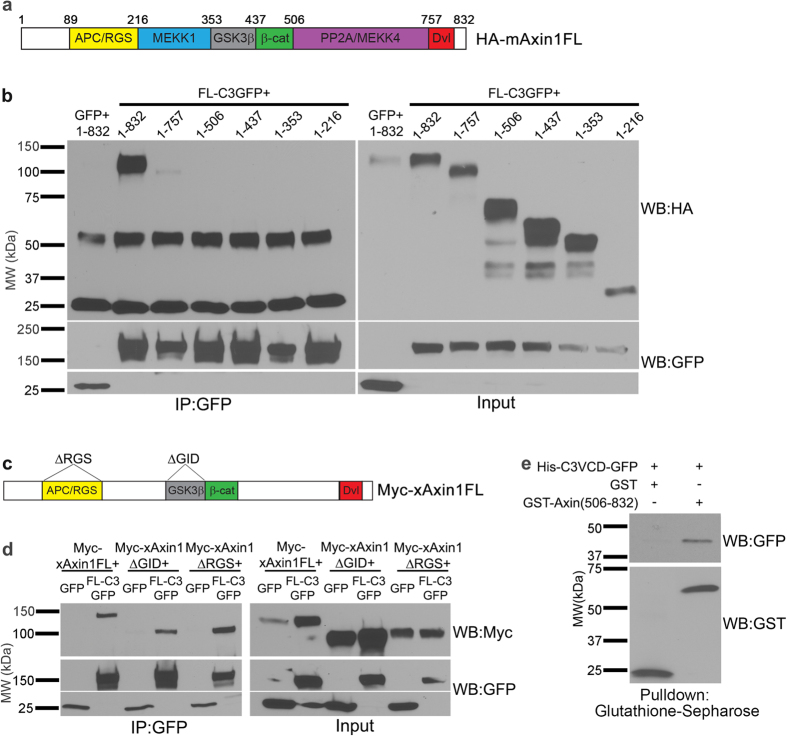
γ-Pcdh-C3 interacts with the DIX domain of Axin1.(a) Schematic of specific protein-protein interacting domains previously identified in mouse Axin1. Numbers above the protein correspond with the amino acid at which C-terminal truncations were made to sequentially remove individual domains. (b) Lysates from HEK293 cells co-transfected with GFP or FL-C3GFP and the HA-tagged full-length mouse Axin1 (1-832); or FL-C3GFP with HA-tagged mouse Axin1 with progressive 3′ deletions (containing amino acids 1-757, 1-506, 1-437, 1-353 or 1-216) were immunoprecipitated with anti-GFP and blotted for HA. Interaction of γ-Pcdh-C3 with Axin1 was abrogated with the loss of amino acids 758-832, indicating the importance of the DIX domain. (c) Schematic of Myc-tagged full length Xenopus Axin1 (Myc-xAxin1FL) and Myc-tagged Xenopus Axin1 with the APC/RGS binding domain (Myc-xAxinΔRGS) or the GSK3β binding domain deleted (Myc-xAxin1ΔGID). (d) Lysates from HEK293 cells co-transfected GFP or FL-C3GFP and Myc-xAxin1FL, Myc-xAxinΔRGS, or Myc-xAxin1ΔGID were immunoprecipitated with anti-GFP and blotted for Myc. Interaction between γ-Pcdh-C3 and Axin1 was observed with all three constructs used, confirming that these internal domains are not critical. (e) Purified His-tagged C3VCD-GFP was mixed with either GST alone, or with GST-Axin(506-832) in a direct binding assay. MW, molecular weight; kDa, kilodaltons.